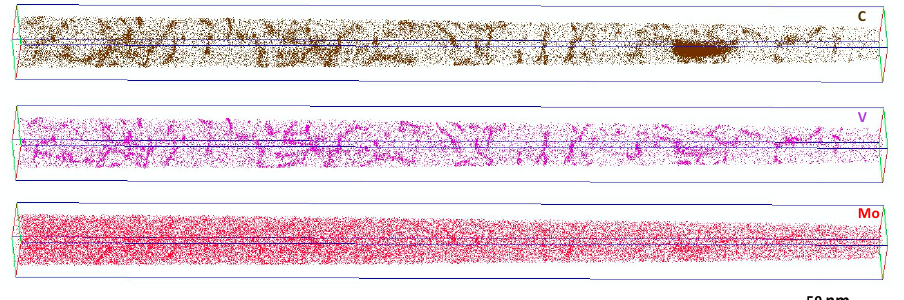
Figure 5. Atom maps of the sample aged 4 h at 600 °C. All atoms are shown for C and V, and 30% for Mo (selected at random). Nucleation of secondary carbides along dislocations can be observed. A part of a large Fe 3 C carbide is seen in the right part of the image.